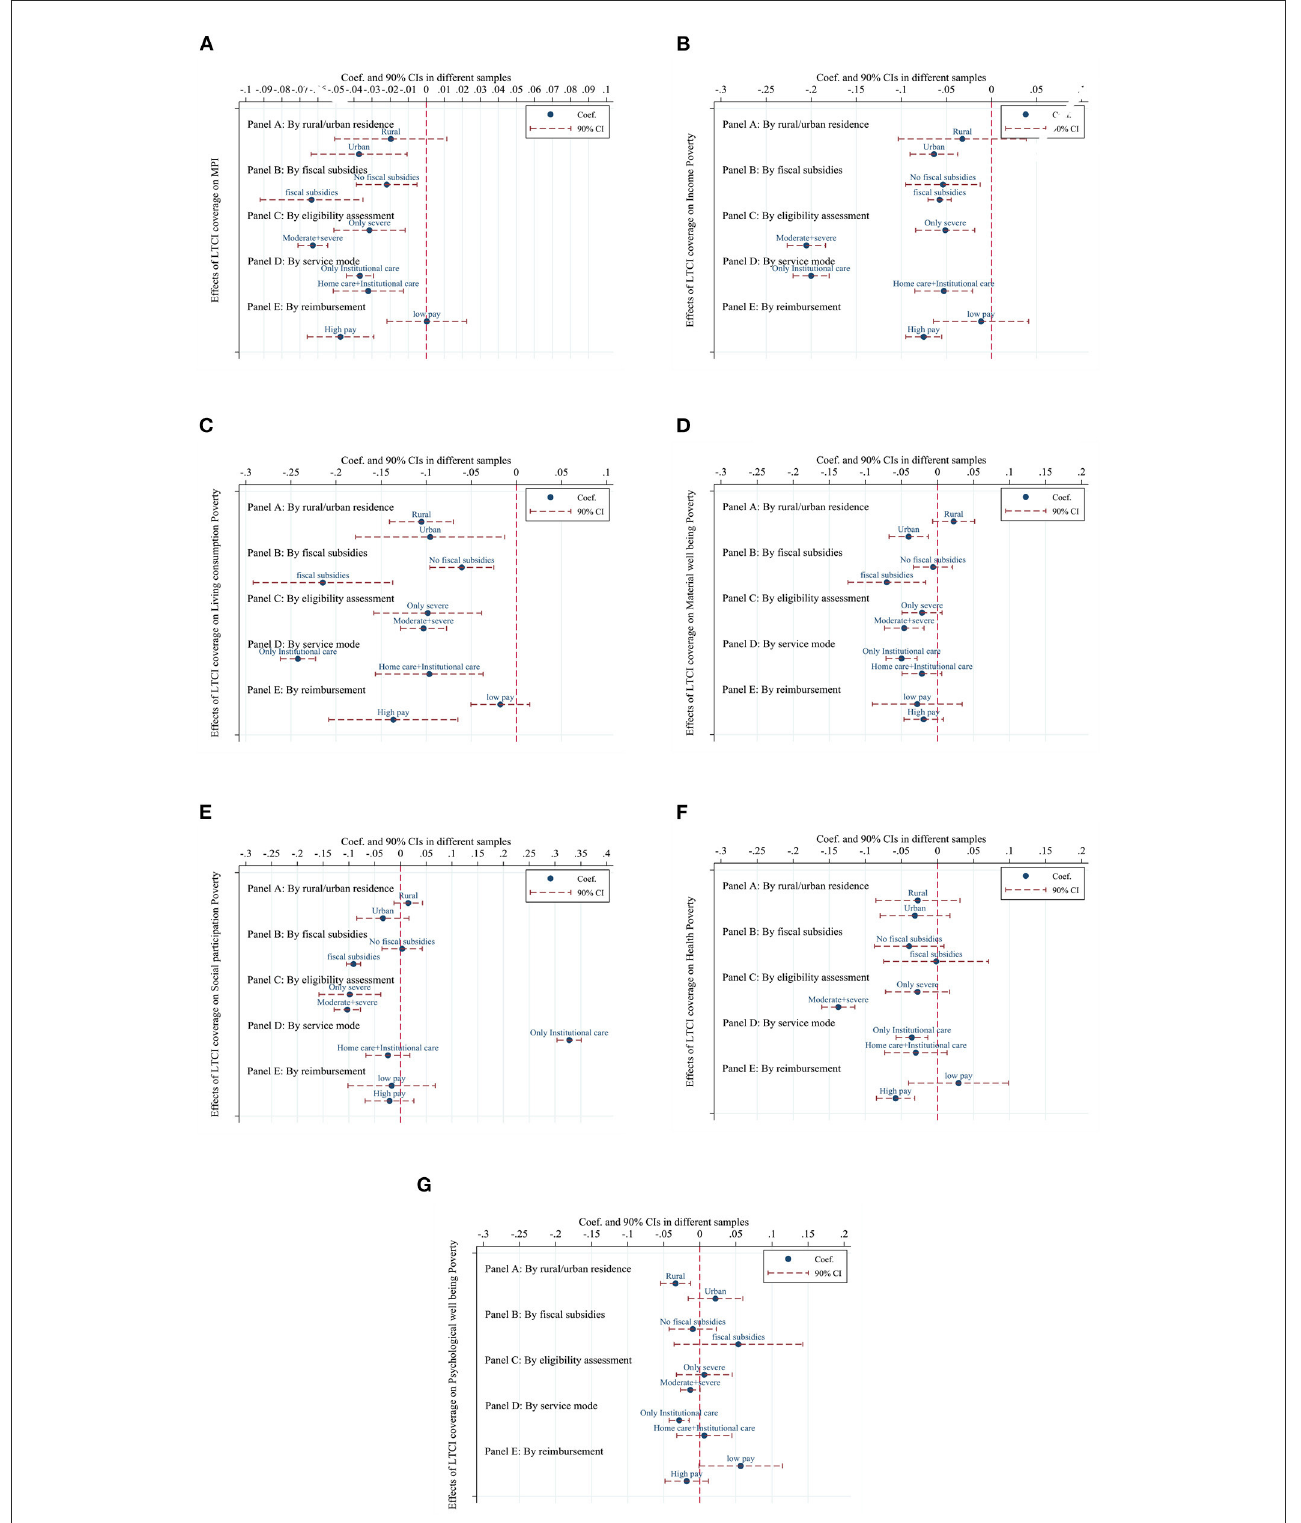
FIGURE4 Heterogeneous effects of LTCI. The figure depicts the coefficients as well as the 90% confidence intervals for the regression analysis. Robust standard errors are clustered at the city level. *** , ** , and * denote 1%, 5%, and 10% significance level, respectively. All regressions control for year FE, individual FE, demographic and socioeconomic covariates, and household-level covariates, as specified in Table 3. (A) , IMD; (B) , Income poverty; (C) , Living consumption poverty; (D) , Material wellbeing poverty; (E) , Social participation poverty; (F) , Health poverty; (G) , Psychological wellbeing poverty.